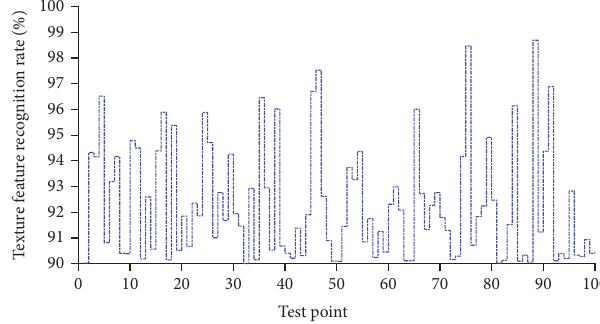
Figure 6: Ladder diagram of texture feature recognition